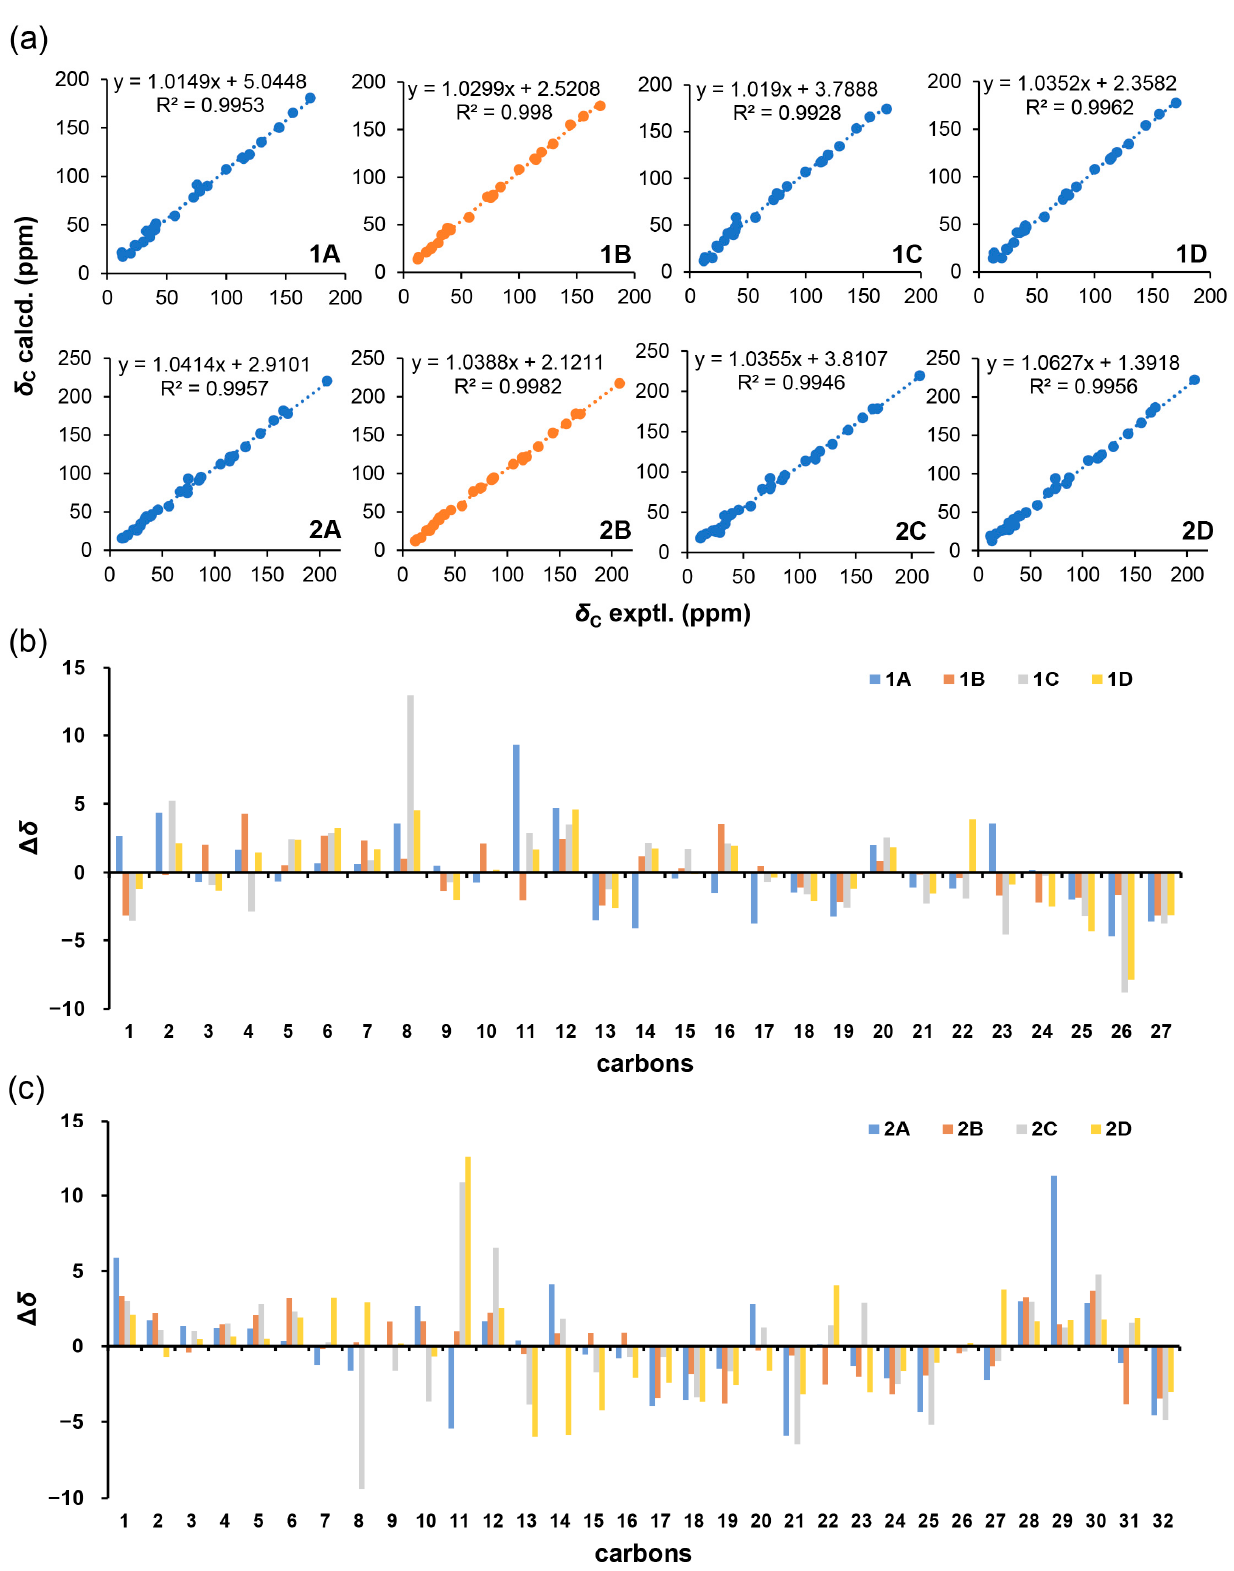
Figure 4. 13 C NMR calculation results of plausible epimers at the B3LYP/6-311++G(2d,p) level. ( a ) Regression analysis of calculated versus experimental 13 C NMR chemical shifts of 1 and 2 . ( b , c ) Relative chemical shift errors between calculated and experimental 13 C NMR data for the experimentally produced 1 and 2 .